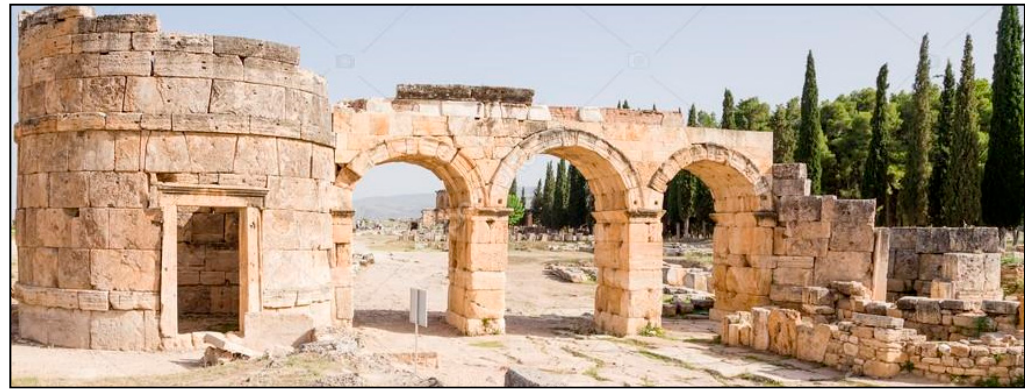
Figure 1. The Frontinus Gate in Hierapolis.